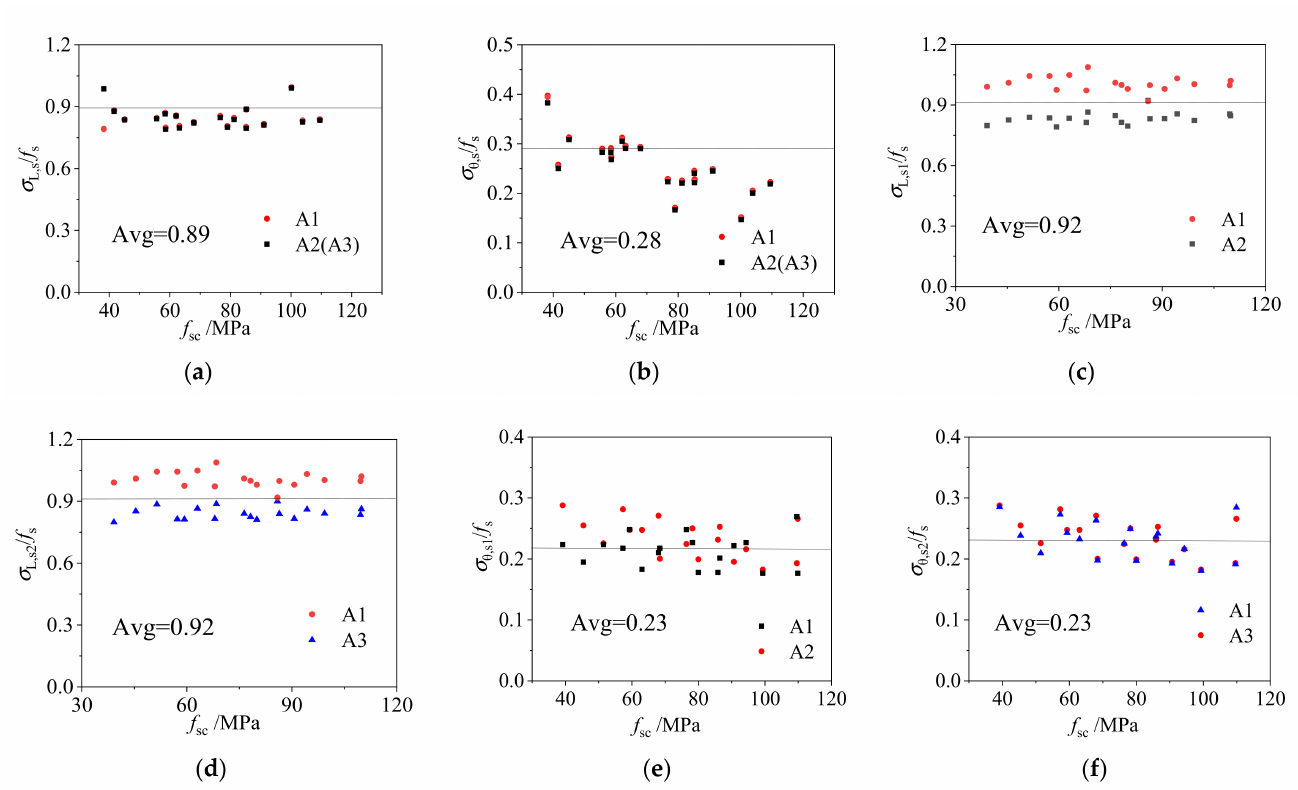
Figure 11. Axial stress and transverse stress of rectangular CFCFST stub columns: ( a ) average ratio of axial compressive stress to yield strength ( B/D = 1), ( b ) average ratio of tensile transverse stress to yield strength ( B/D = 1), ( c ) average ratio of axial compressive stress to yield strength on long-side ( B/D = 2), ( d ) average ratio of axial compressive stress to yield strength on short-side ( B / D = 2), ( e ) average ratio of tensile transverse stress to yield strength on long-side ( B / D = 2), and ( f ) average ratio of tensile transverse stress to yield strength on short-side ( B / D =